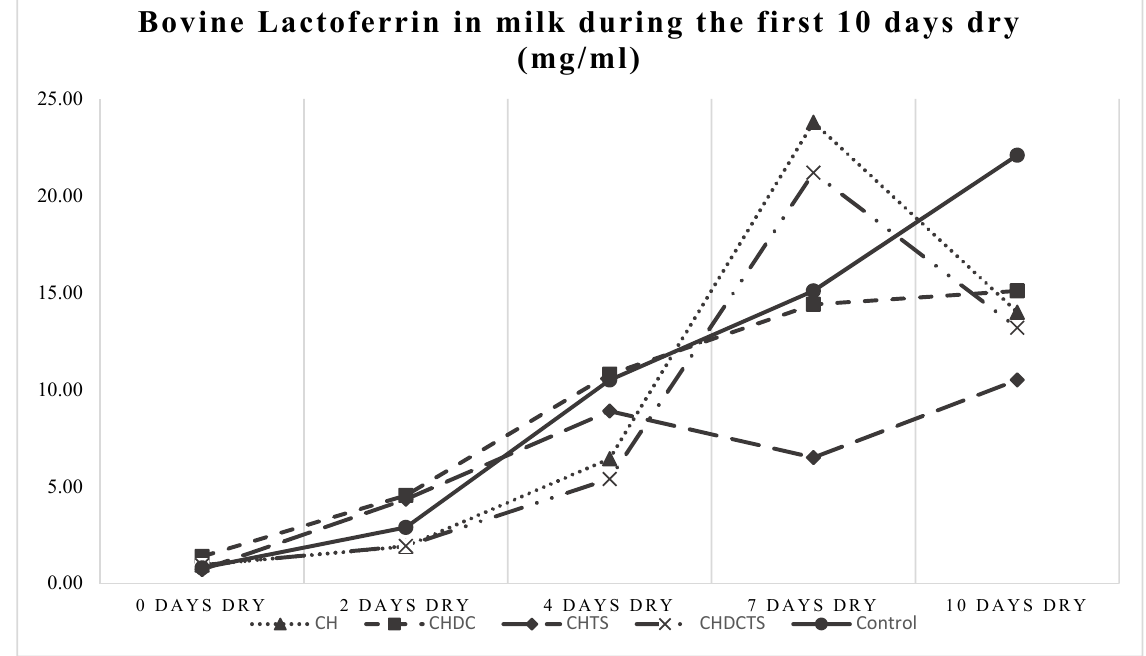
Figure 2. BLf by days dry and dry treatment group; CH treatment group different from CHDC, CHTS and control at 7 days dry ( p < 0.05, GLIMMIX). CH = casein hydrolysate; CHDC = casein hydrolysate + dry cow treatment; CHTS = casein hydrolysate + teat sealant; CHDCTS = casein hydrolysate + dry cow treatment + teat sealant; Control = dry cow treatment + teat sealant.